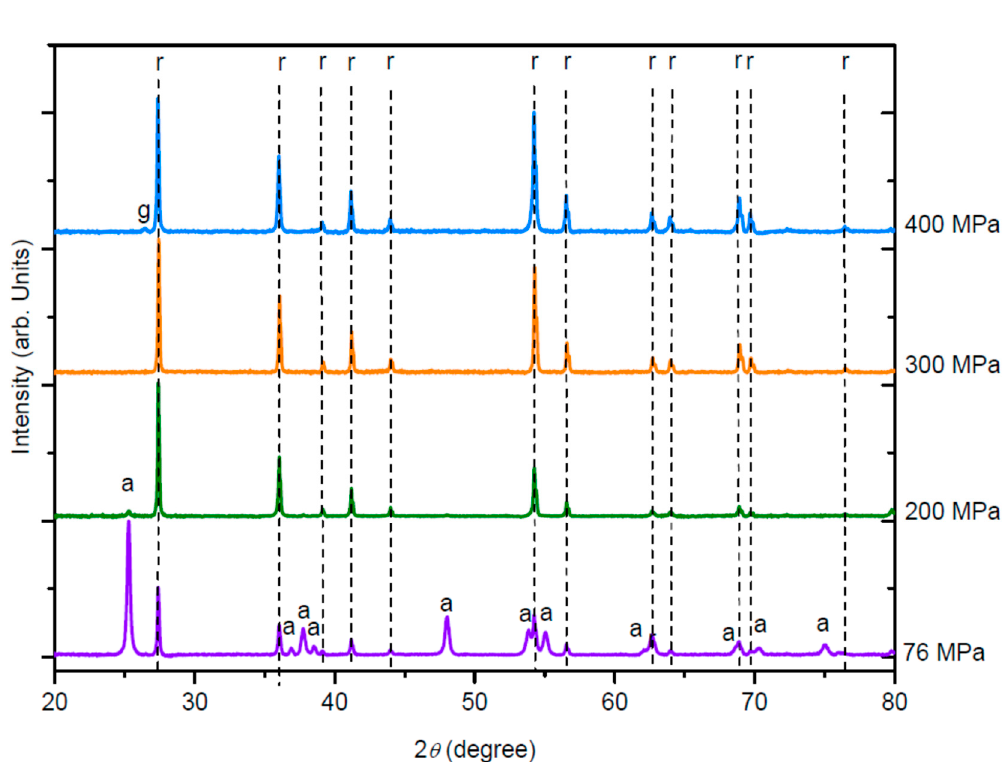
Figure 2. XRD patterns of the materials obtained after spark plasma sintering (SPS) cycle up to 700 °C at the different pressures. The peaks are identified as the anatase phase ( a ) and the rutile phase ( r ) in the samples. ( g ) Corresponding to graphite residue (originating from the graphite foil placed between the WC mold and the sample during sintering) present on the surface of a sample.